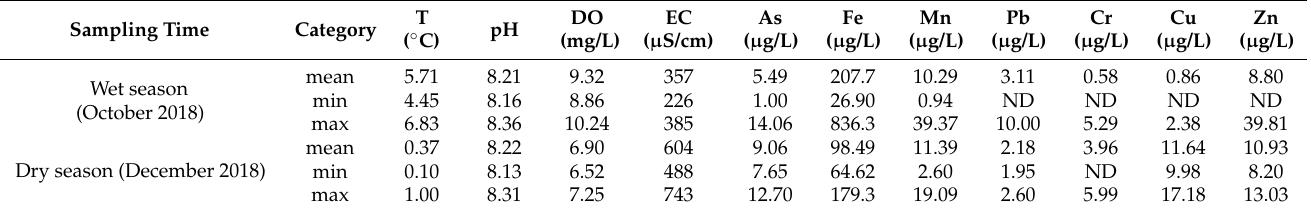
Table 5. Field parameters and trace element concentrations in surface waters from the upper Lancang River.